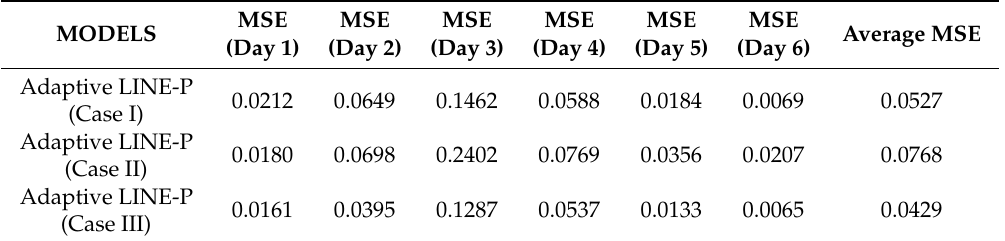
Table 3. Error comparison of adaptive LINE-P (all cases) based on the MSE for SDG&E solar energy profile.